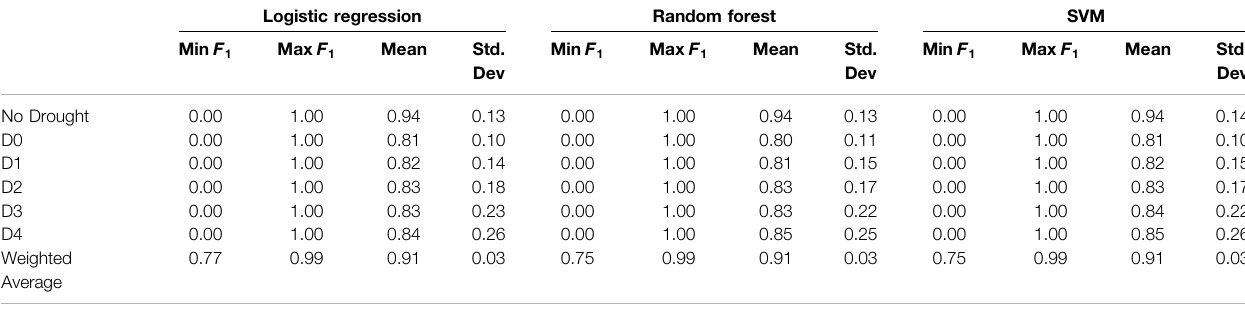
TABLE 5 | Descriptive statistics of the models performances uing Group 2 input features over the entire domain. Logistic regression Random forest SVM